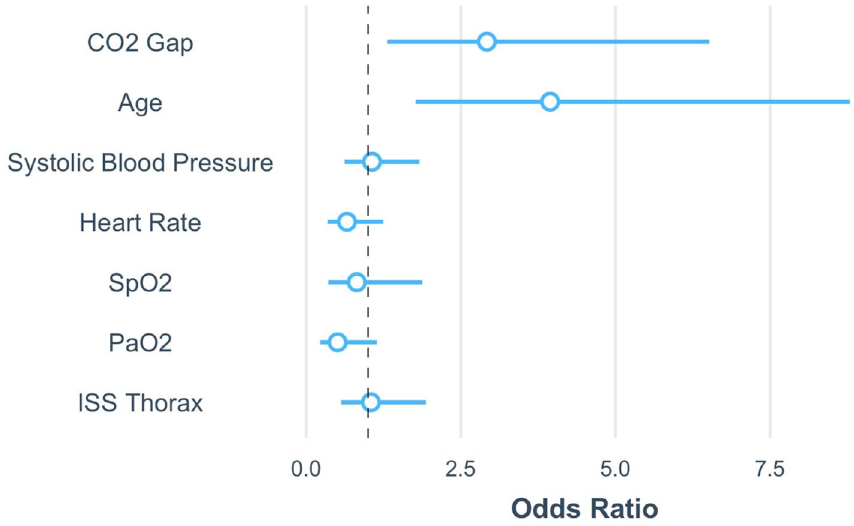
Figure 4. Scaled regression coefficient of the multivariate logistic regression. Illustration of the multivariate logistic regression model summarized on Table 3. Regression coefficients are exponentiated and scaled. The horizontal lines around the dots indicates the 95% confidence interval of the odds ratio. CO2 gap = PaO2— EtCO2. Figure was created using RStudio (2020). RStudio: Integrated Development for R. RStudio, PBC, Boston, MA URL http:// www. rstud io. com/. and the package ggplot2 by Wickham H